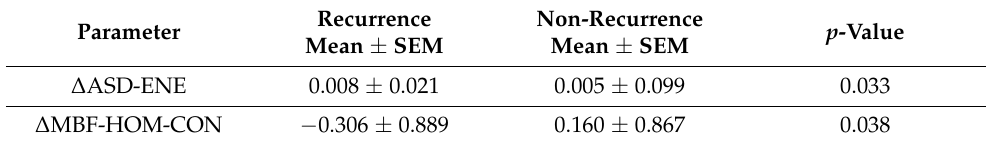
Table 2. Features with significant differences at week four into neoadjuvant chemotherapy.